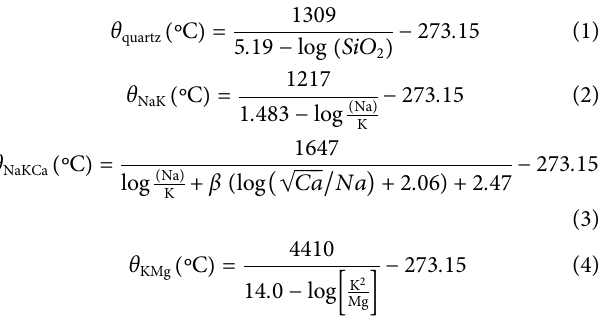
Frontiers in Earth Science |